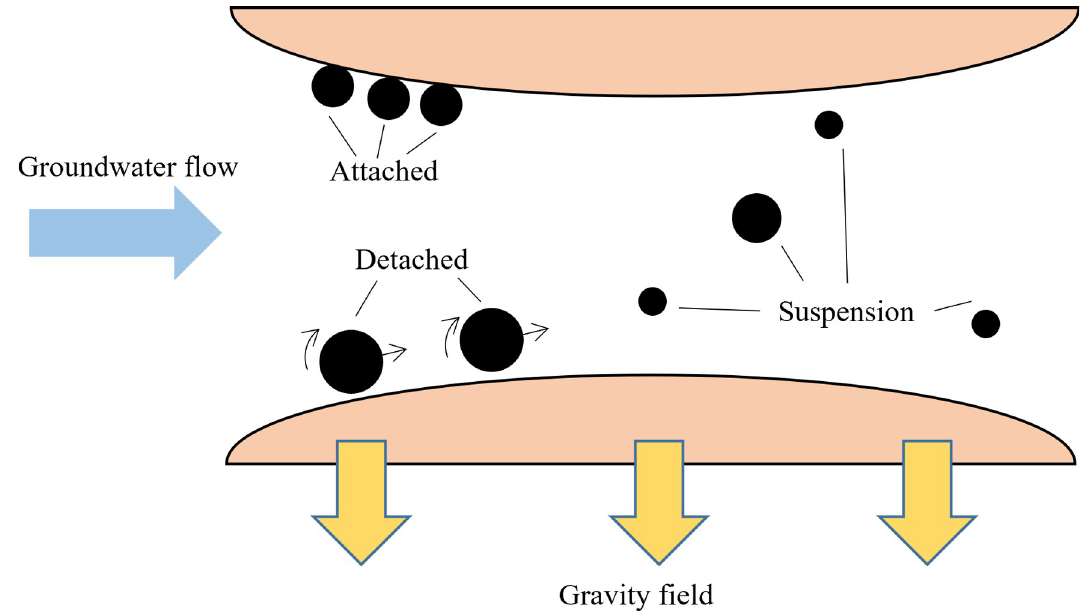
Fig 1. Schematic of cplloids attachment and